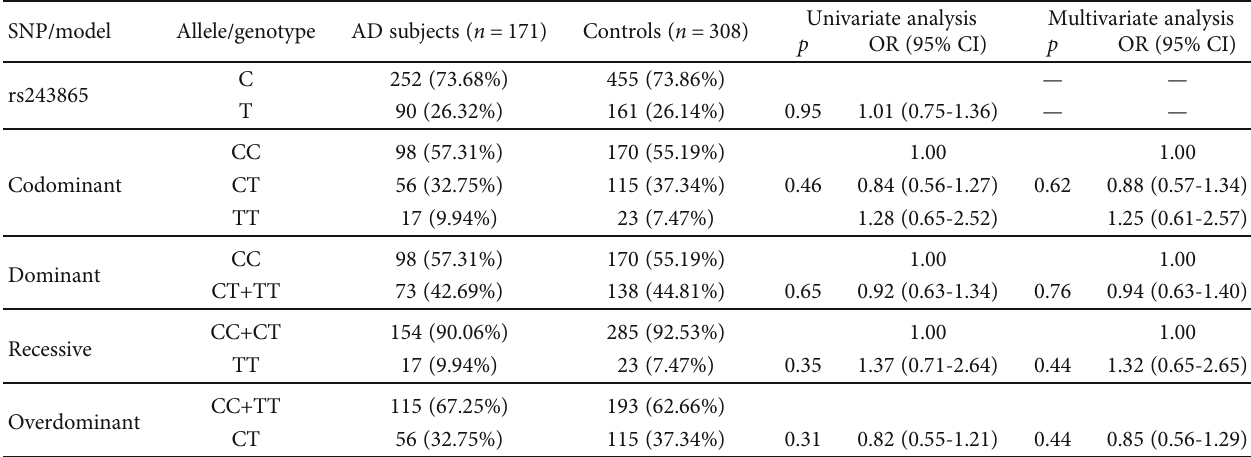
Table 2: Allele and genotype frequencies of MMP2 polymorphism rs243865 (-1306 C/T) in AD patients and controls.